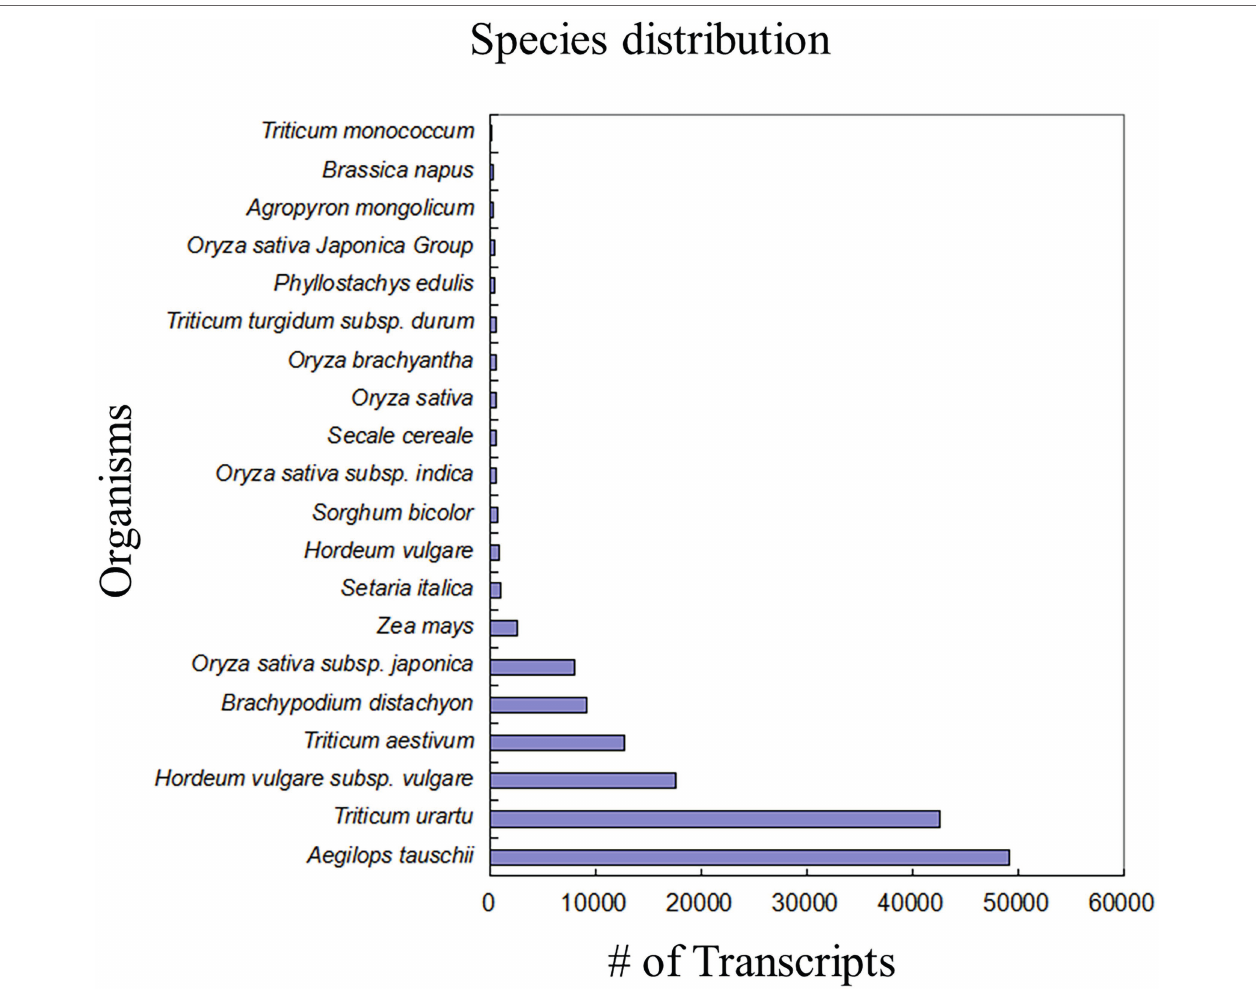
FIGURE 2 | Bar graph representing the species distribution of annotated DEGs. Maximum number of annotated DEGs was represented by Aegilops tauschii (49204) followed by T. uratu (42504). Triticum aestivum falling at the fourth place had approximately 10,000 annotated